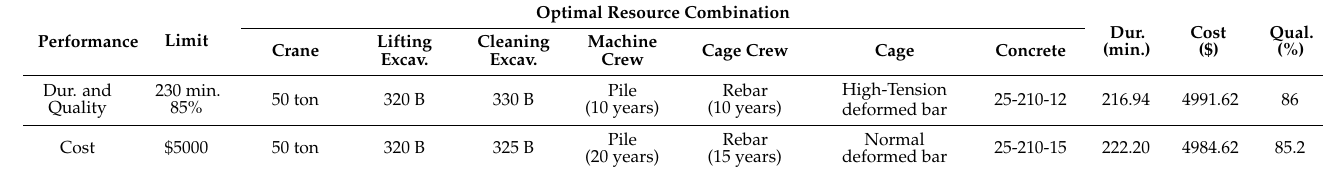
Table 6. Optimal resource combination based on prioritization of performance indicators and simulation results.